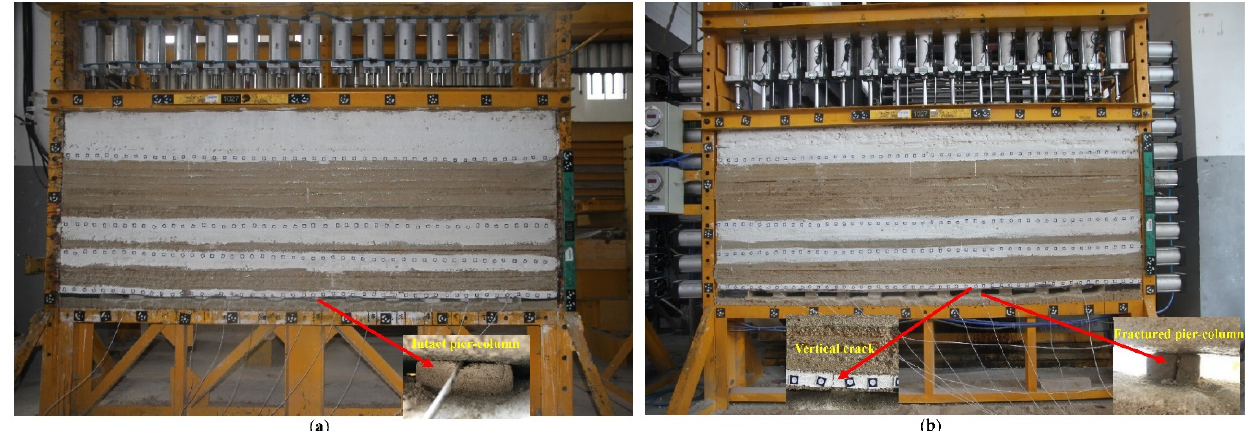
Figure 9. View of the bearing performance of backfilled pier-column with a different mining thickness: ( a ) 2 cm; ( b ) 4 cm.